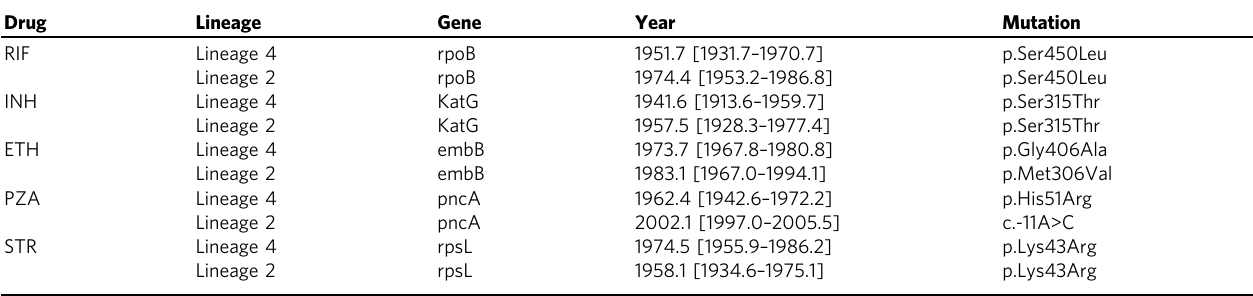
Table 2 First emergence of drug resistance conferring mutations in Lima, Peru.